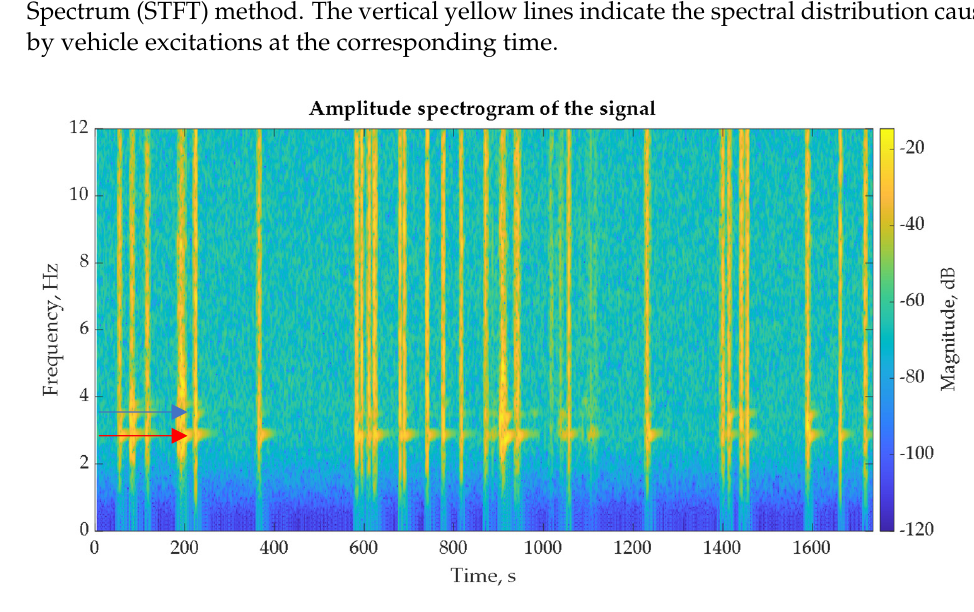
Figure 15. Short Time Fourier Spectrum of sensor 5 at vertical axis. Figure 16. Short Time Fourier Spectrum of sensor 5 at transverse axis (Y axis). Based on the identified frequencies, the graphical display of the mode shapes is a preliminary check for their reliable assessment. The procedure for the static graphical